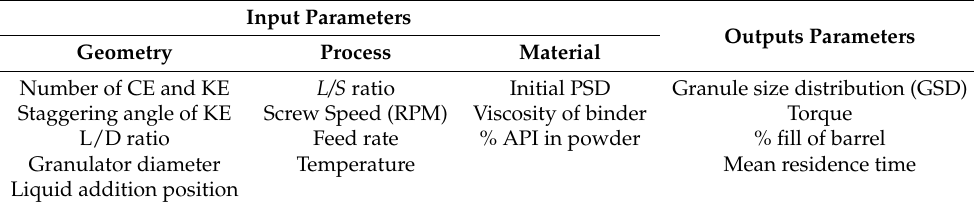
Table 2. Inputs and outputs for the development of the regime